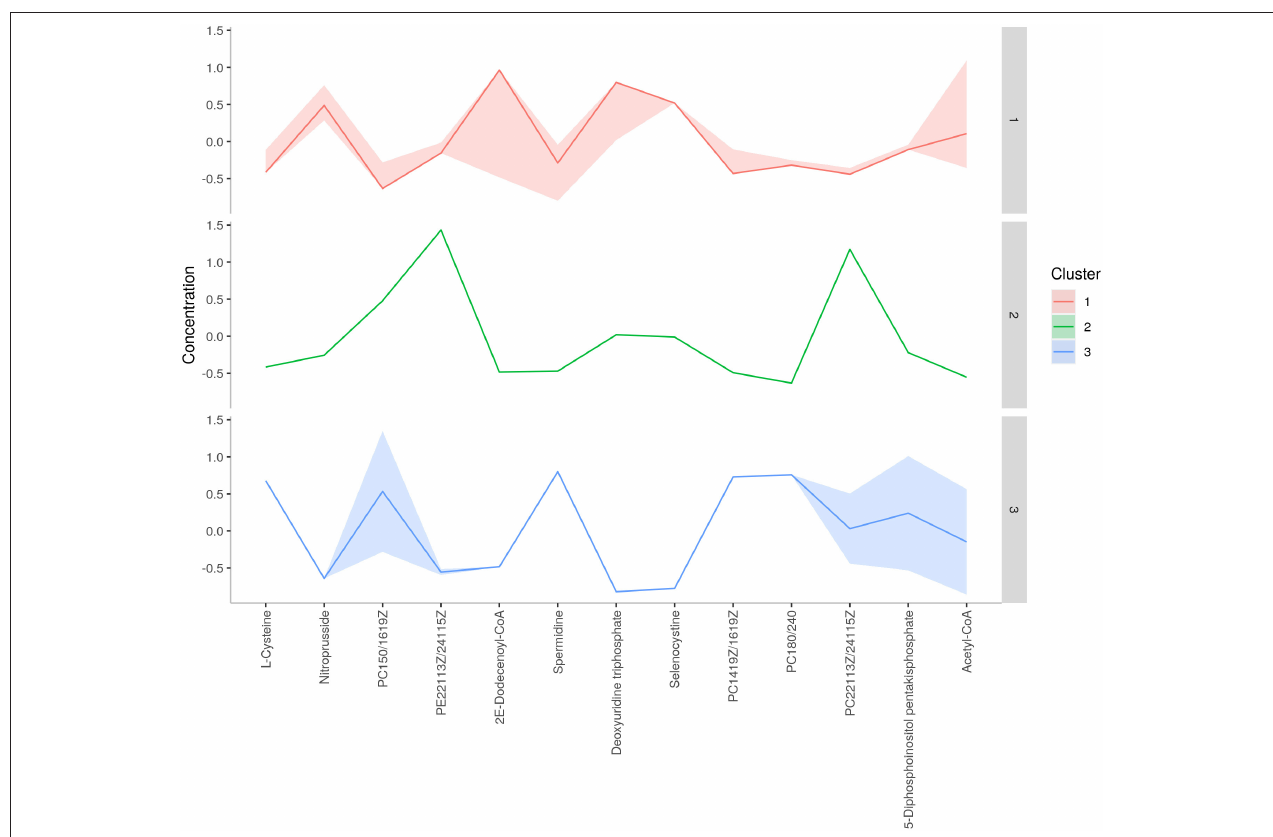
FIGURE 4 | K -means clustering of spermatozoa metabolites of astheno-oligozoospermia bulls.